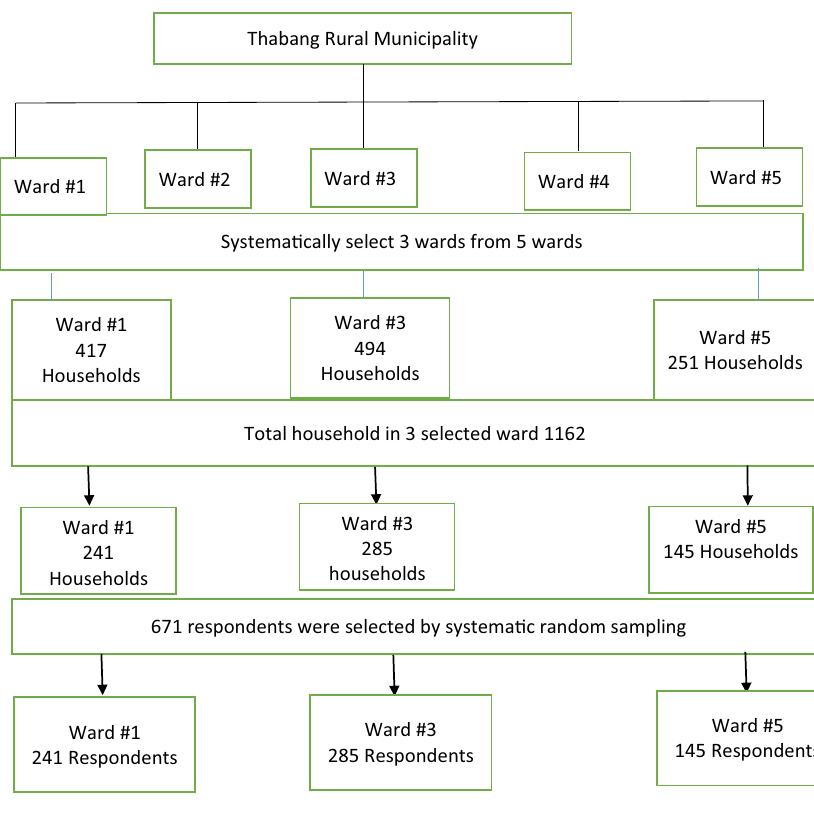
Figure 1. A diagram of the sampling